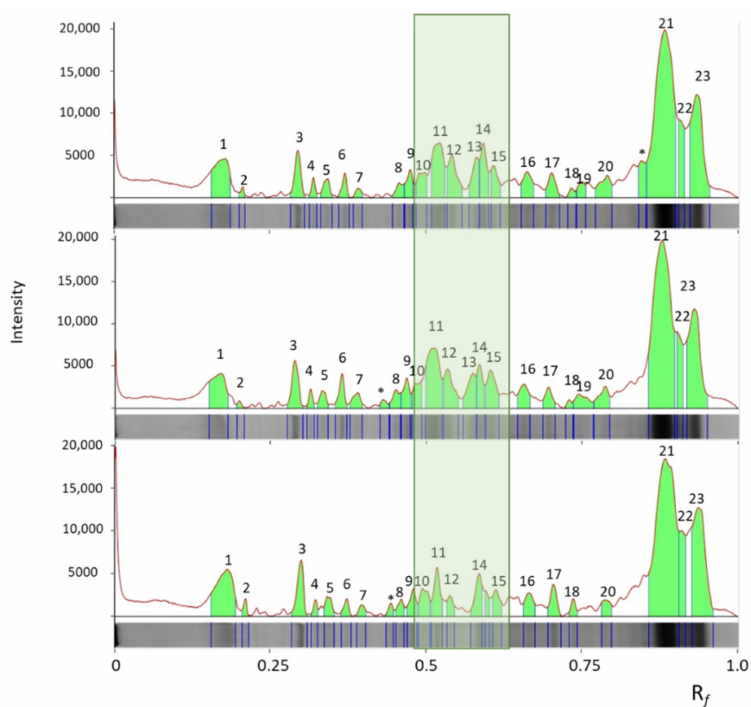
Figure 6. Pherograms obtained from the SDS-PAGE gel reported in Figure 5: lanes 2 (fraction 11, sample A), lane 3 (fraction 11, sample B), and lane 4 (fraction 11, sample C) from the top to the bottom of the figure. In the rectangle, the central zone of the pherogram, containing the excised bands 2, 3, 4, and 6, is outlined, highlighting the different intensities of the protein bands. In the three pherograms, the same peaks are marked by the same number. The peaks present only in one or two pherograms are marked with an asterisk. R f is the migration distance of the protein band through the